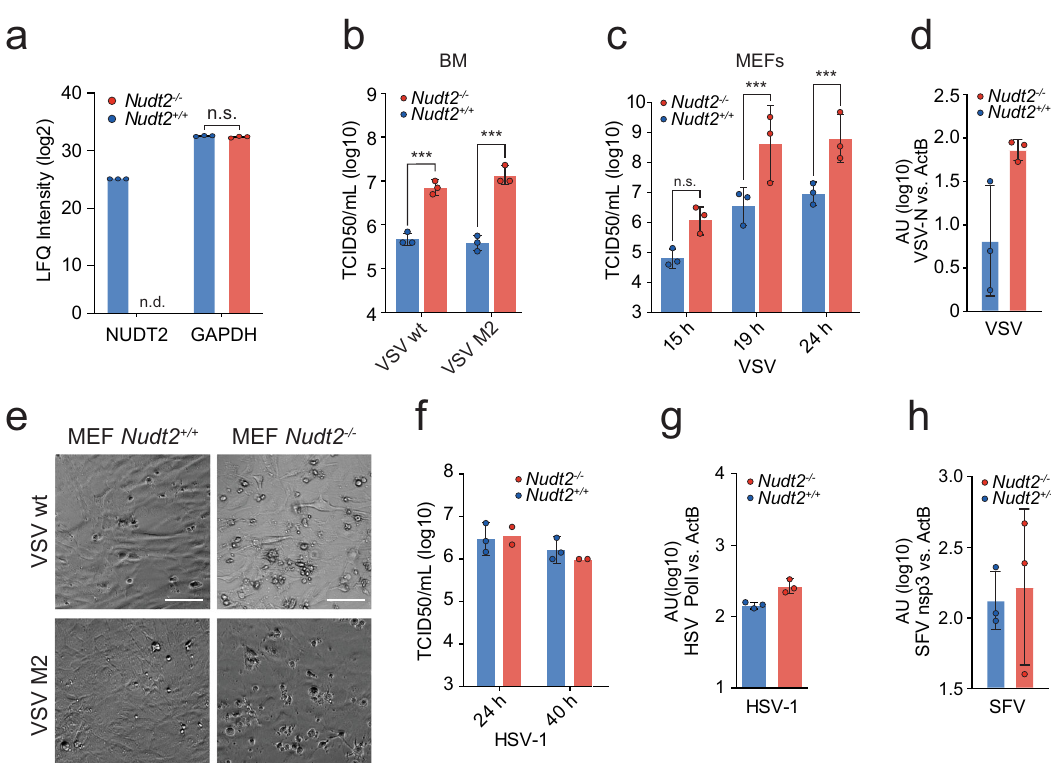
Fig. 6 Impact of NUDT2 on virus growth. a Bone marrow cells were isolated from Nudt2 knockout ( Nudt2 − / − ), and control mice were tested for the abundance of NUDT2 by mass spectrometry. The mean LFQ intensities ± SD for NUDT2 and GAPDH of six biological replicates are shown. A two-sided students t-test (FDR 0.05) was performed. b Accumulation of infectious virus particles in supernatants of Nudt2 + / + or Nudt2 − / − bone marrow infected with either wild-type VSV, VSV-M2 at an MOI of 1 for 16 h. The average TCID50/mL of three biological replicates ± SD are shown. *** p < 0.001 two-way ANOVA with Bonferroni ’ s post-test. c Accumulation of VSV in supernatants of Nudt2 + / + and Nudt2 − / − MEFs infected with VSV at an MOI of 0.001 for 16 h. Average TCID50/mL of three biological replicates ± SD. *** p < 0.001, two-way ANOVA with Bonferroni ’ s post-test. d Viral RNA load in Nudt2 + / + or Nudt2 − / − MEFs infected with VSV. RNA levels were quanti fi ed by RT-qPCR analysis using speci fi c primers for the VSV nucleoprotein transcript. Data were normalized to murine ActB RNA. The mean ± SD of three biological repetitions are shown in arbitrary units. e Phase-contrast micrographs of Nudt2 + / + or Nudt2 − / − MEFs infected with VSV for 16 h. The scale bars represent 100 µ m. MEF cells of the indicated genotype were infected with HSV-1 ( f , g ) or SFV ( h ) at an MOI of 2 for 16 h. f Accumulation of infectious virus particles was analyzed. The graph shows the average TCID50/mL of three biological replicates ± SD. g , h Accumulation of viral RNA quanti fi ed by RT-qPCR analysis using speci fi c primers for the DNA polymerase I of HSV or nsp3-transcript of SFV. Data were normalized to murine ActB RNA. Bar plots show average arbitrary units of three biological repeats ±